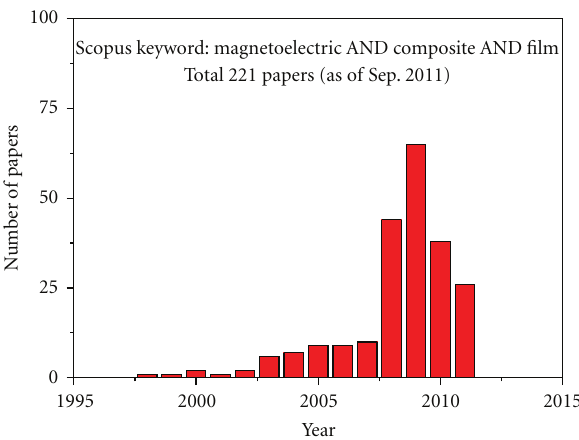
Figure 3: The year wise number of articles published in the literature on the magnetoelectric composite thin/thick